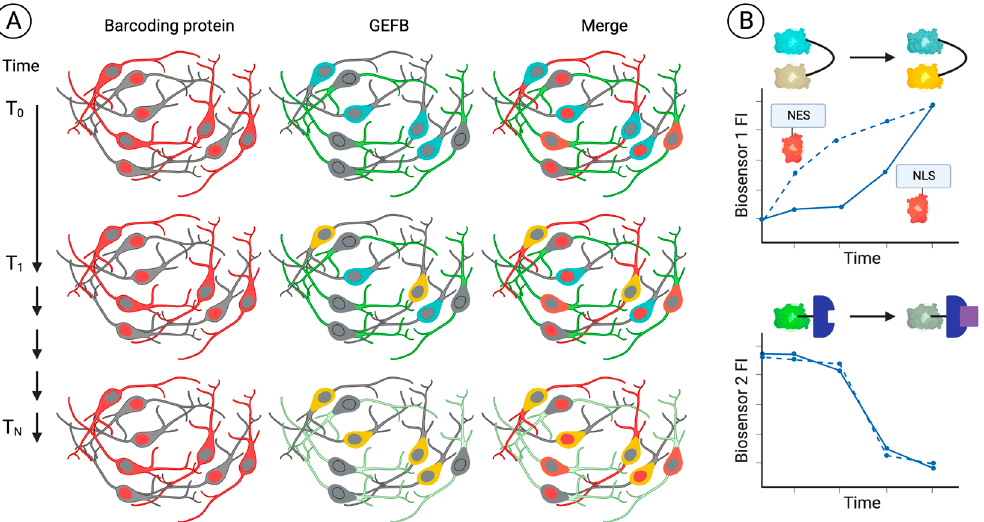
Figure 4. Barcoding proteins and GEFBs enable cell-specific quantitation of cell responses in multi- plexed cultures. In pooled cultures of neurons expressing barcoding proteins and GEFBs, barcoding protein expression would remain stable over time, whereas GEFB expression changes ( A ). Quanti- tation of GEFB imaging can reveal changes occurring at different or the same rate in specific bar- coded cell populations ( B ).